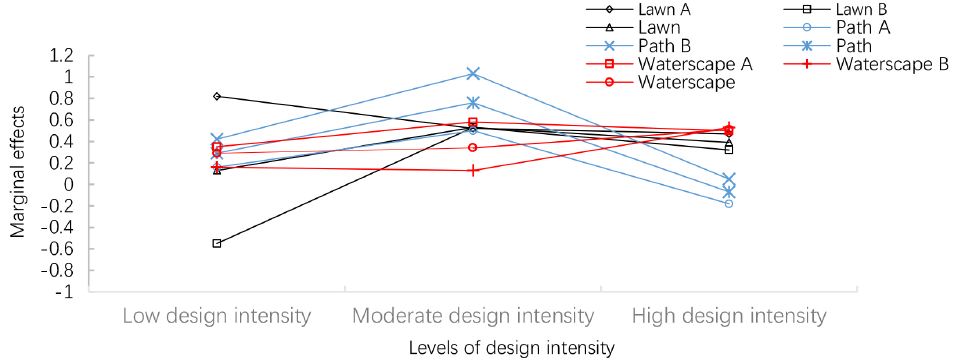
Figure 4. Marginal effects of three design intensities on landscape preference in each group and type of landscape.